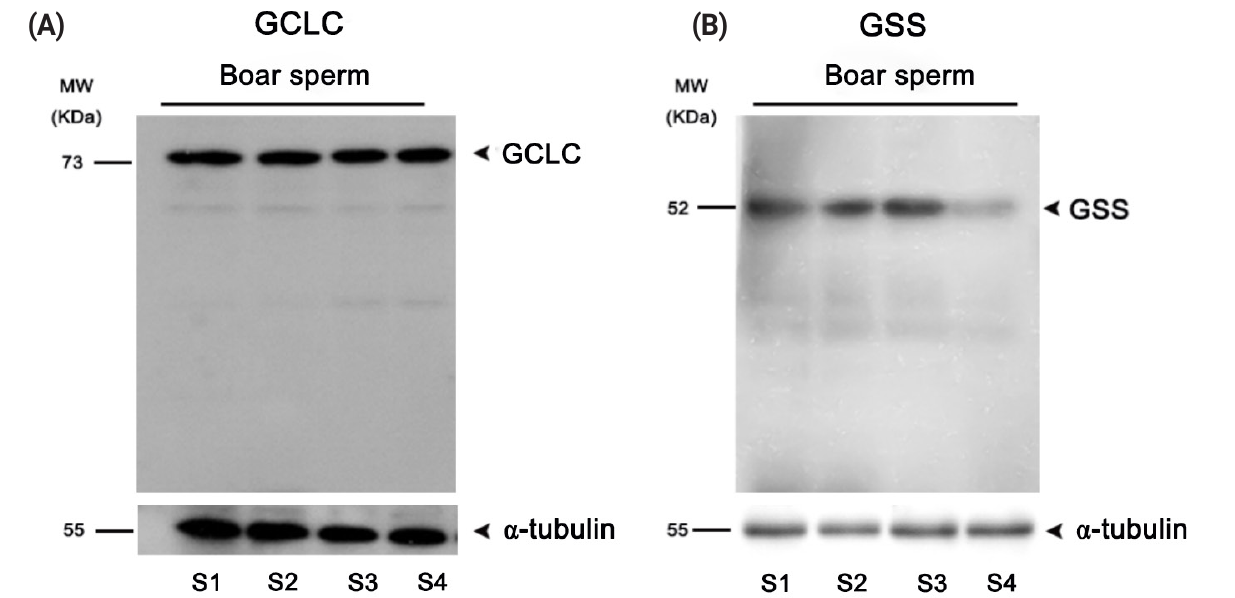
Figure 5. Western blotting detection of (A) the GCLC and (B) GSS enzymes in boar sperm. GCLC, glutamate cysteine ligase; GSS, glutathione syn - thetase; S1-4,